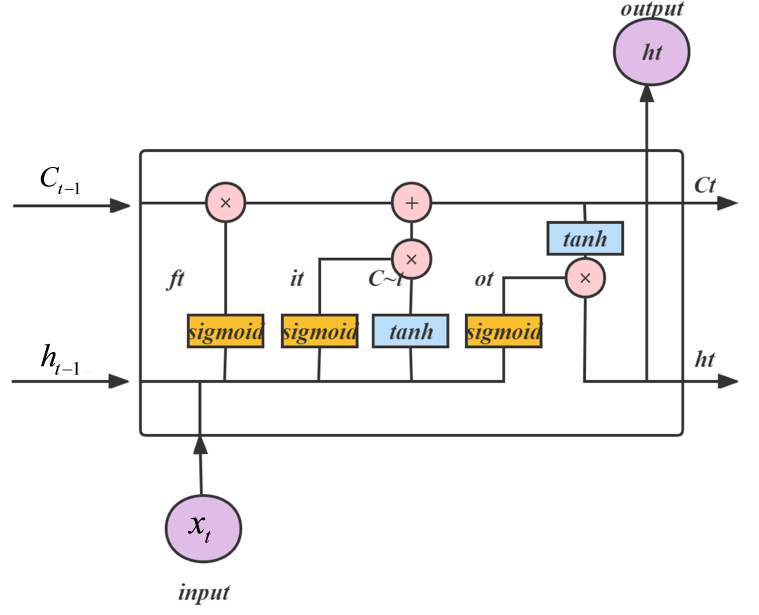
Figure 1. Schematic diagram of the state of the LSTM